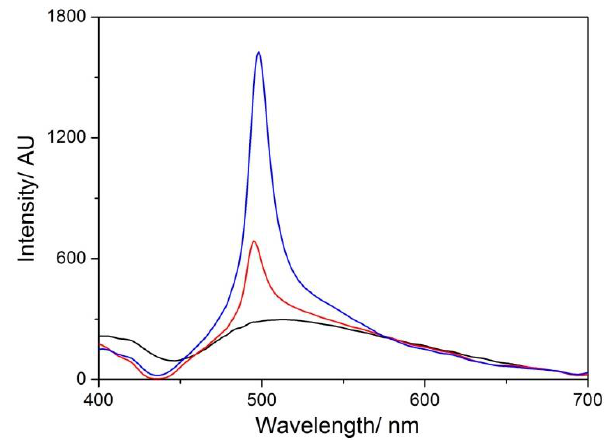
Figure 6. RLS spectra of MWCNT-EPA (black line), after TPPS addition (red line), and 1 day after mixing (blue line). Experimental conditions: [TPPS] = 5 µM; MWCNT-EPA = 0.02 mg/mL; 10 mM citrate buffer at pH 2.4; PL protocol; T = 298 K.